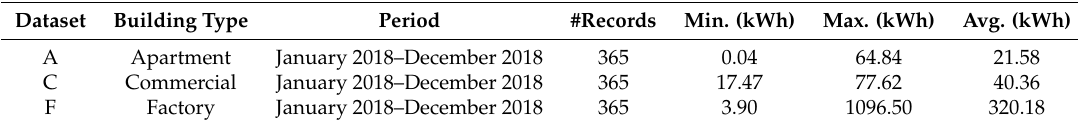
Table 1. Electricity data details